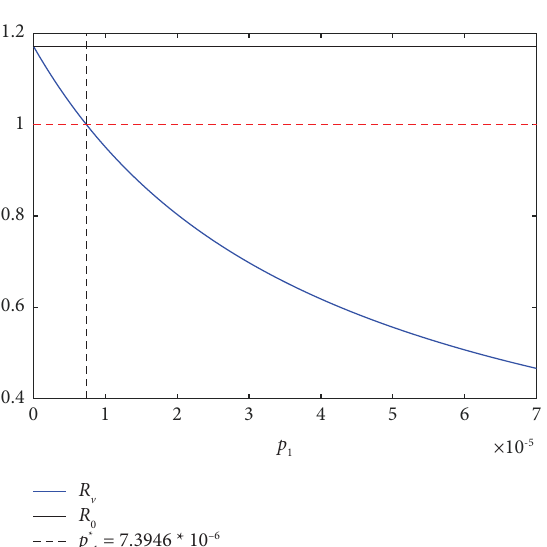
Figure 3: Te role of the vaccination rate p line is used to mark the horizontal line at 1. p ∗